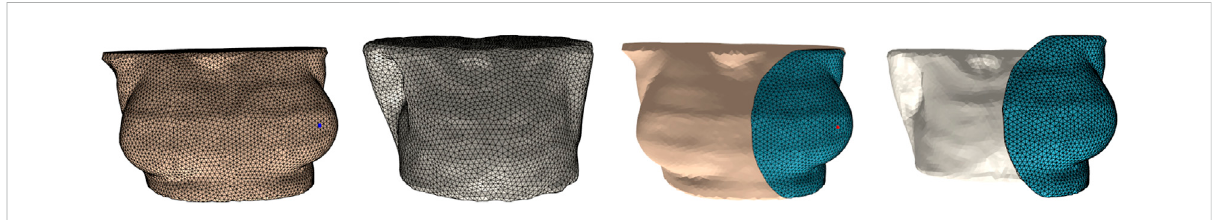
FIGURE 2 Main components of the simulation model.From left to right: (i) segmentation and meshing ofsurface skin from the CT-scan, (ii) segmentation and meshing of the chest wall from the CT-scan, (iii) simulation mesh, obtained by selecting a portion of the skin corresponding to the breast, (iv) combination of the simulation mesh and the chest wall that acts as boundary